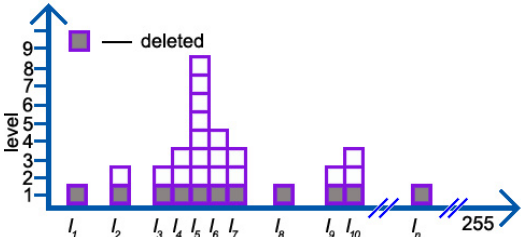
Figure 5. The number of squares in each column represents the number of intensity values in this column; for instance, the number of intensity values I 5 is eight. Squares in Level 1, colored in gray, will be deleted according to number of intensity values